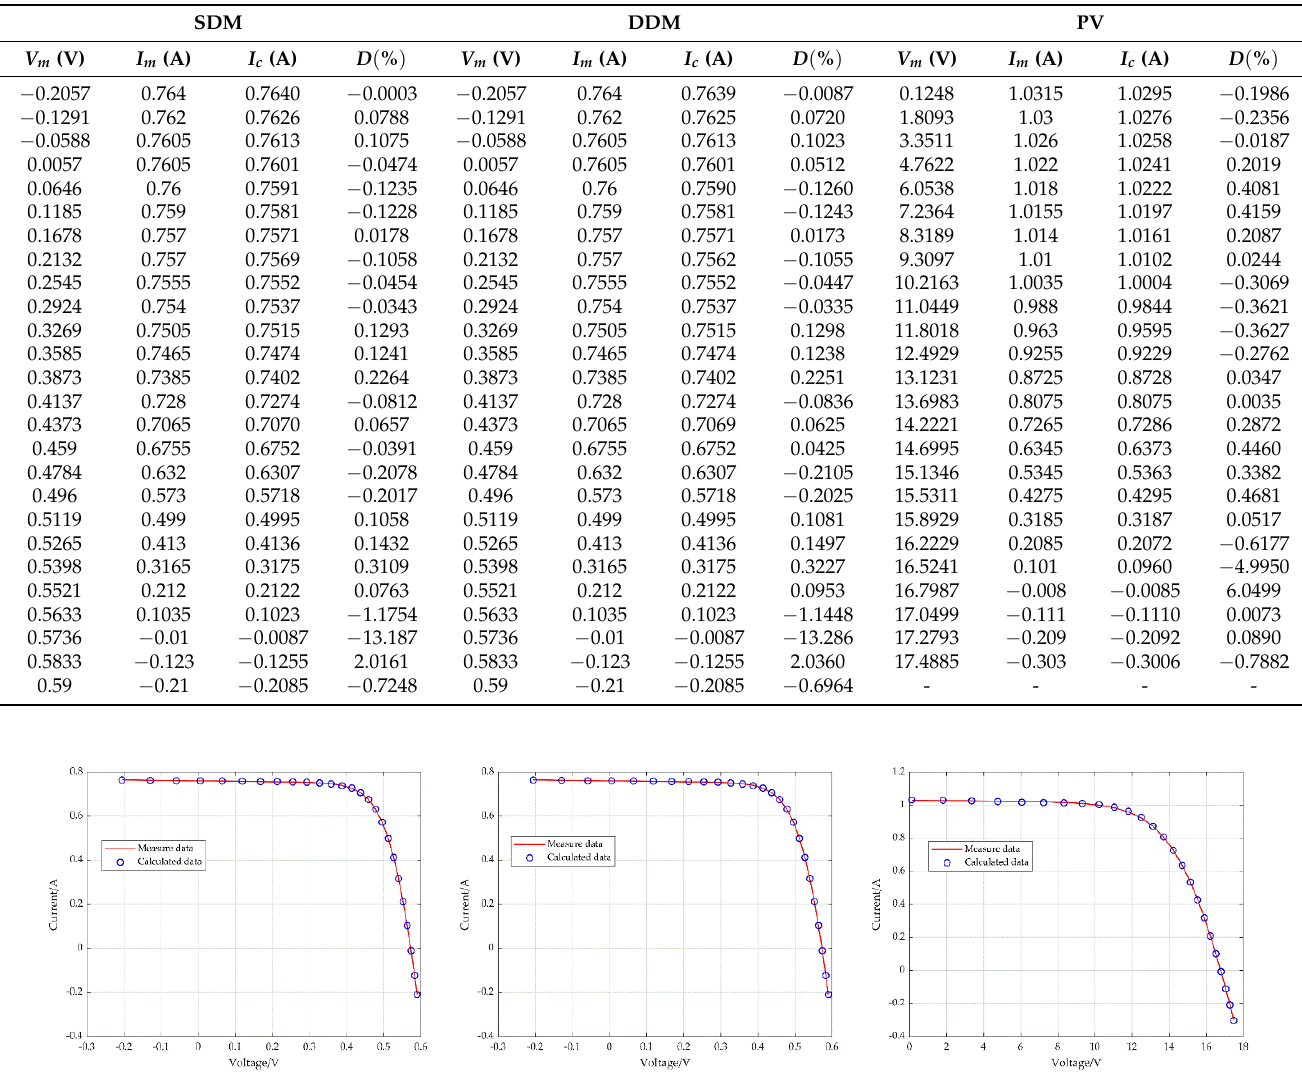
Table 6. Simulation results of using the DCWPA for three models solution.